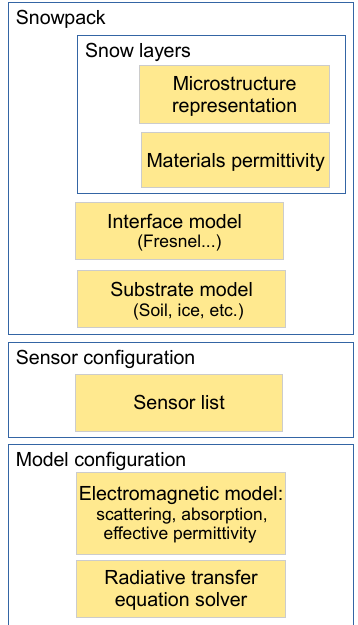
Figure 2. SMRT architecture and main components. The core com- ponents (blue) are fixed and contain no scientific code in contrast to the switchable and extensible components (orange), which define the snowpack and model